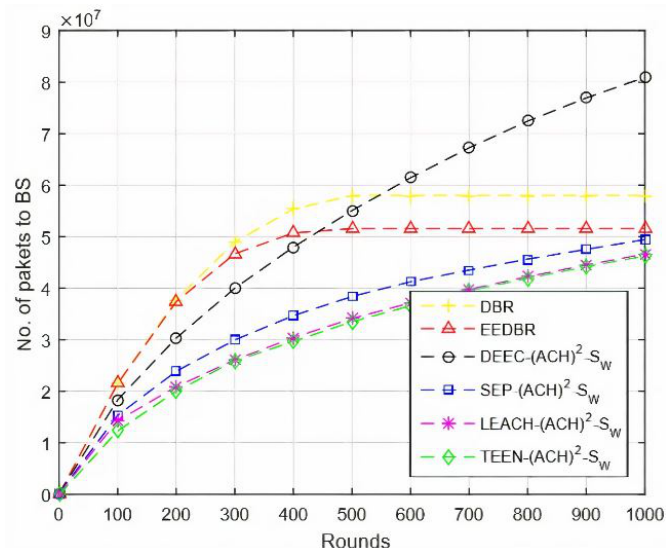
Figure 5. Number of Packets Sent to Base Station